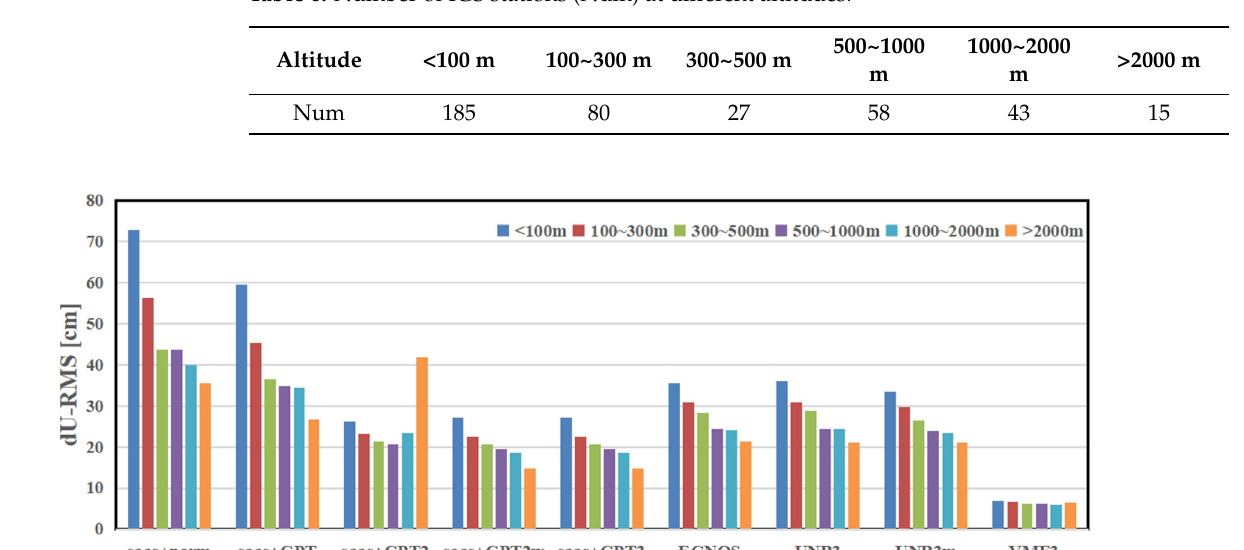
Figure 11. RMSs of the vertical SPP biases by using the nine models at different heights (unit: cm).